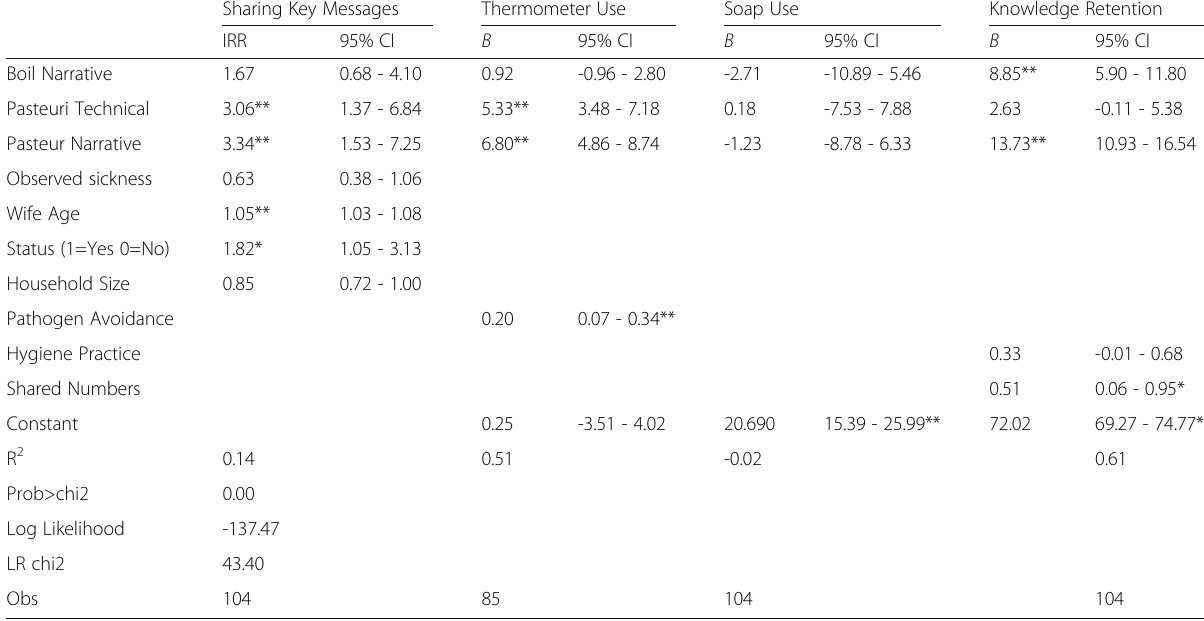
Table 2 Reduced models for household intervention outcomes. IRR is incidence rate ratios from negative binomial regression while B are beta coefficients from OLS. R 2 for sharing key messages is pseudo R 2 and adjusted R 2 for OLS